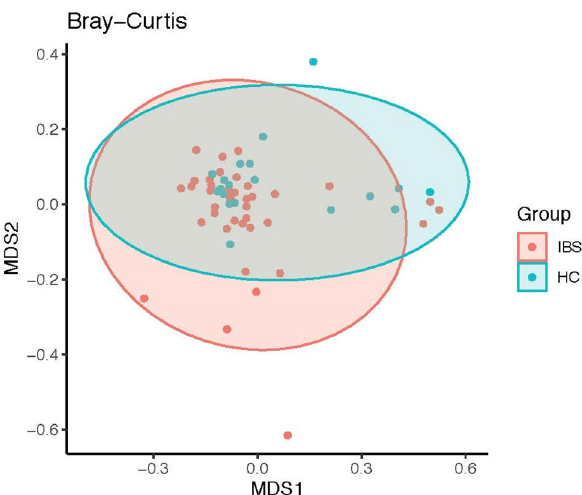
Figure 5. Fecal microbiome dissimilarity using Bray–Curtis distance between IBS and healthy control (HC)